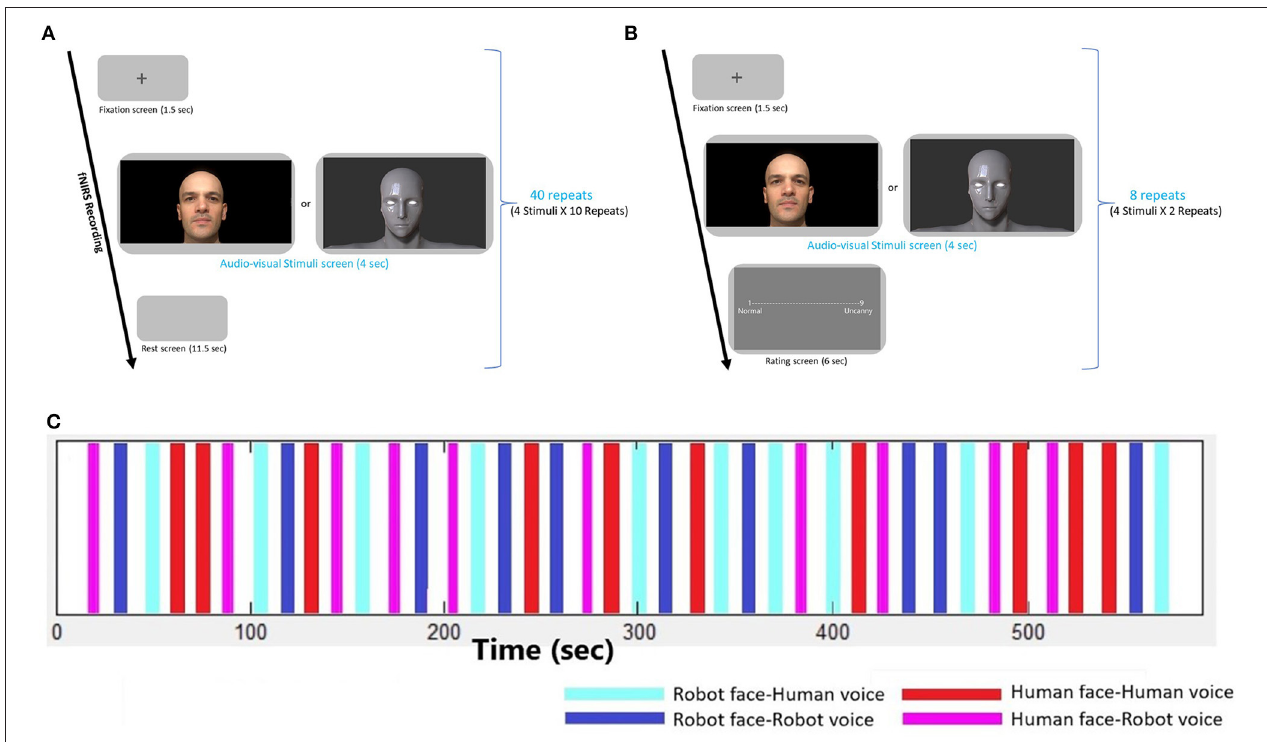
FIGURE 2 | Experimental design. (A) Experimental design of the fNIRS recording session, (B) Experimental design of the Behavioral session, (C) Time traces depicting the onsets and durations of each audio-visual stimulus during the fNIRS recording session. Four types of stimuli are repeated 10 times in a randomized